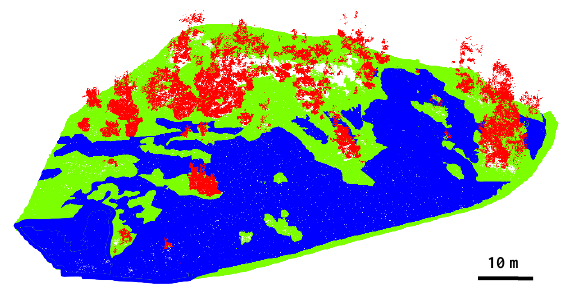
Figure 8. The three considered categories for the UAV-based point cloud: bare ground, in blue, undergrowth, in green and high vegetation, in red.